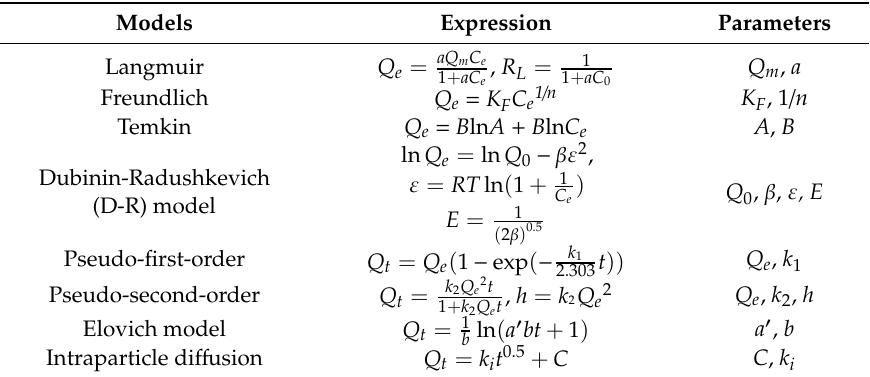
Table 1. The list of kinetic and isotherm models.